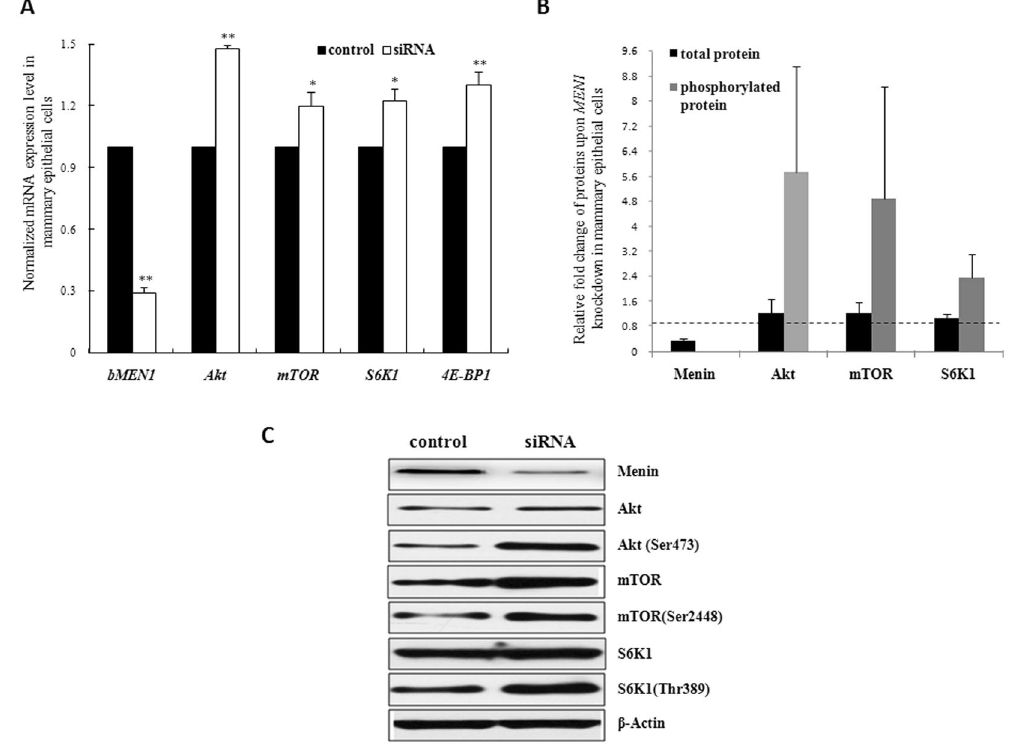
Figure 1. MEN1 knockdown promoted the expression of genes that regulate milk protein synthesis in mammary epithelial cells. The expression levels of factors involved in the PI3K/Akt/mTOR pathway (Akt, mTOR, S6K1 and 4E-BP1) that are associated with milk protein synthesis were assessed at the mRNA (( A ) n = 3) and total protein (( B ) n = 3) levels by quantitative real-time PCR (qRT-PCR) and WB, respectively, in MAC-T cells at 24 h after transfection with a non-specific control (control) or a MEN1 specific siRNA pool (siRNA). The phosphorylation levels of Akt at Ser473, mTOR at Ser2448, S6K1 at Thr389 and 4E-BP1 at Thr37/46 were detected simultaneously. The data are shown as the relative expression levels normalized to the internal control, β -actin. * P < 0.05, ** P < 0.01. The horizontal dashed line represents the normalized level of their corresponding controls. Representative WB images of the expression of Menin, Akt, Akt phosphorylated at Ser473, mTOR, mTOR phosphorylated at Ser2448, S6K1 and S6K1 phosphorylated at Thr389 are shown in ( C ). PI3K, phosphatidylinositol-3-kinase; Akt, also known as protein kinase ( B ) Akt (Ser473), Akt phosplorylated at Ser473; mTOR, mammalian target of rapamycin; mTOR (Ser2448), mTOR phosplorylated at Ser2448; S6K1, p70 ribosomal protein S6 kinase-1; S6K1 (Thr389), S6K1 phosplorylated at Thr389; 4E-BP1, eukaryotic initiation factor 4E (eIF4E)-binding protein